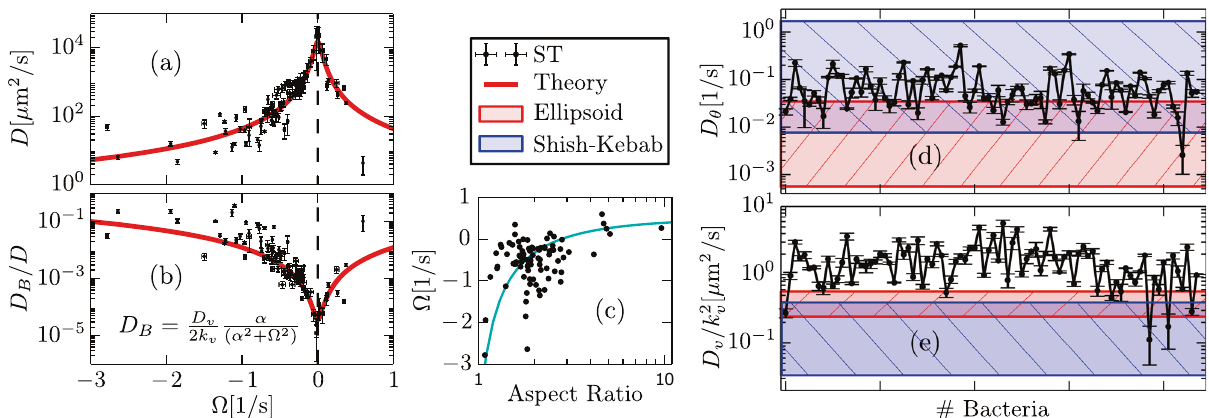
Fig. 3 Variability of individual diffusion coef fi cients and origin of fl uctuations. a Individual diffusion coef fi cient D of ST-WT as a function of Ω . The symbols correspond to experimental estimations and the red curve corresponds to D AV ( Ω ), whose expression is given in the text. The relative importance of speed fl uctuations, given by D B / D to the estimation of D is shown in b ; α = D θ + k v . There seems to exist a correlation between Ω and the aspect ratio ω of bacteria as indicated in c ; the solid curve is a guide to the eye. d and e show the measured values for D θ and D v = ð k 2 v Þ , respectively, and compares them with the expected range of values for thermal fl uctuations using the so-called ellipsoid (red color) and Shish-Kebab (blue color) model 38,39 , see text and Supplementary Note 4. All error bars correspond to SE and were computed by Gaussian propagation of